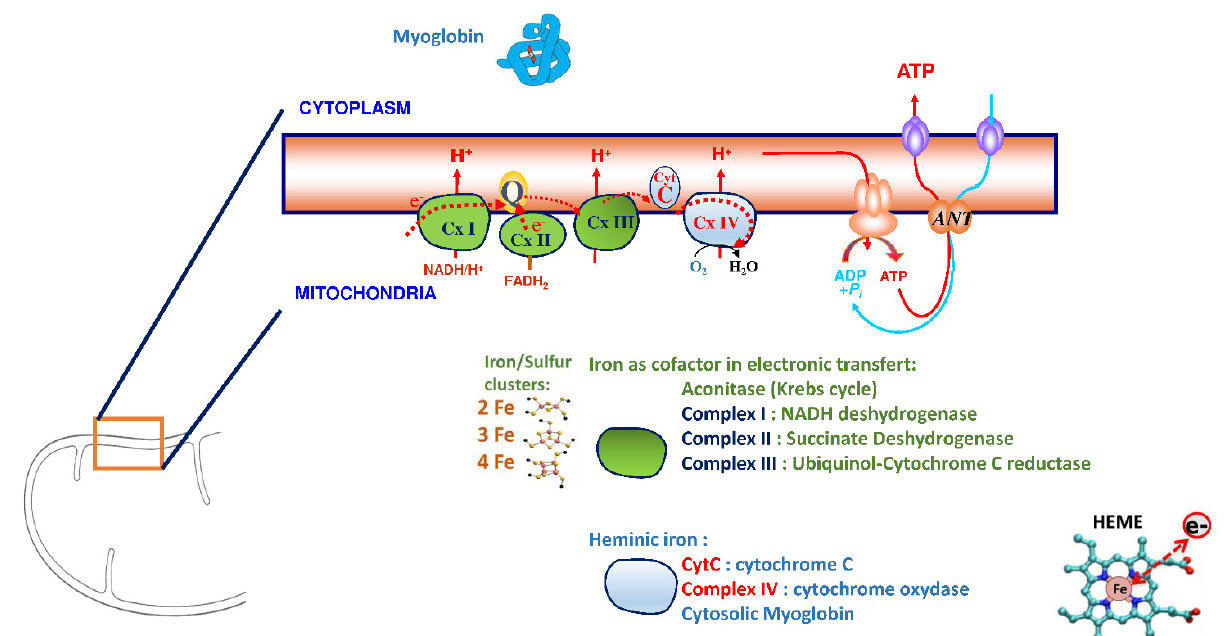
Figure 2. Role of the iron outside of hematopoiesis. Iron is an essential cofactor in most proteins involved in oxidative phosphorylations and anti-oxidative enzymes. As shown in the present figure, iron is a constitutive element of numerous proteins, either as a component of the heme ring in hemoproteins (such as Myoglobin, involved in muscle oxygenation, or cytochromes, involved in oxido-reductive reactions) or in iron–sulfur clusters involved in electronic transfers.